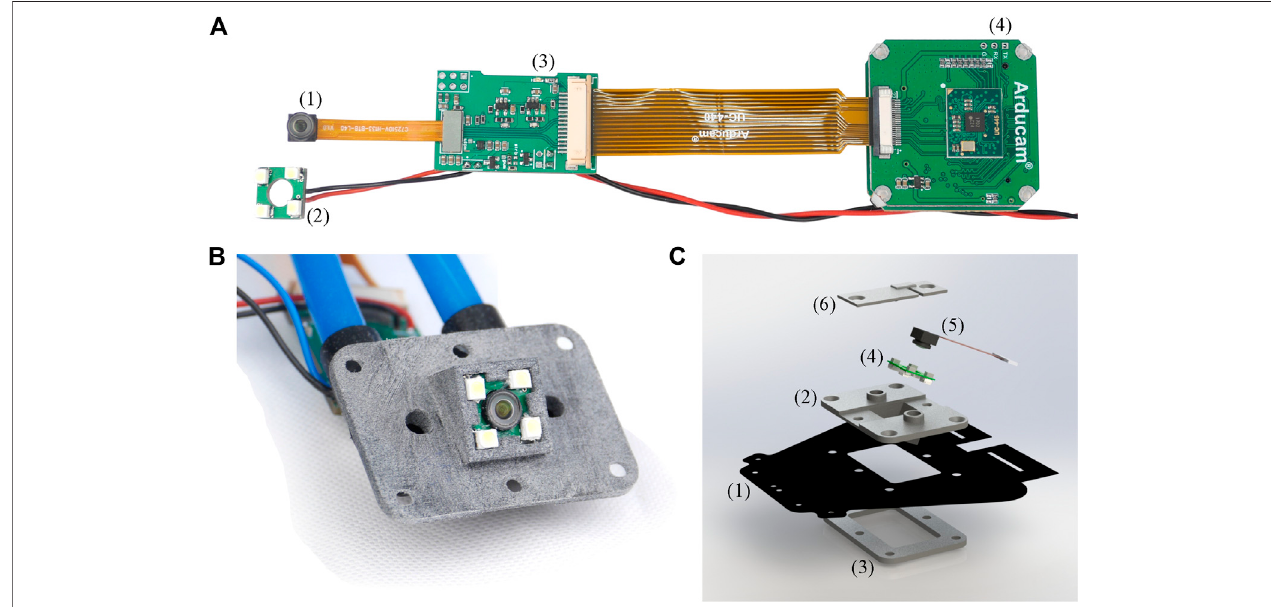
FIGURE4|(A) The fi gureshowsthecameraelectronicsusedineachactuator.Thecamera(1)andLEDboard(2)areconnectedtoacustom-madeadapterboard (3) which reroutes the camera pins and powers the LED board. The adapter board includes pins which are used for synchronizing multiple cameras and is powered through the black/red cables. The adapter board isconnected to an Arducam USB Camera Shield (UC-425 Rev. C) with USB interface (4). The USB cable is notshown forbettervisibility. (B) Thepicture showsthefrontviewofthecameraadapter housingthecamera and theenclosing LEDboard. Thecamera istilted byanangleof 25 + with respect to the normal direction of the adapter plane. The pressure is measured and controlled over the blue tubing connected to the adapter over black angle connectors and routed to the two openings next to the camera. (C) The fi gure shows a rendering of the camera interface. The bottom fabric layer (1) is sandwiched betweenthecameraadapter(2)anda3Dprinted fl angering(3)andisfastenedusingsixscrews.TheLEDboard(4)andthecamera(5)areinsertedintotheadapterfrom the top and the camera cable is routed through a slit in the top piece (6). Silicone glue is used to seal all